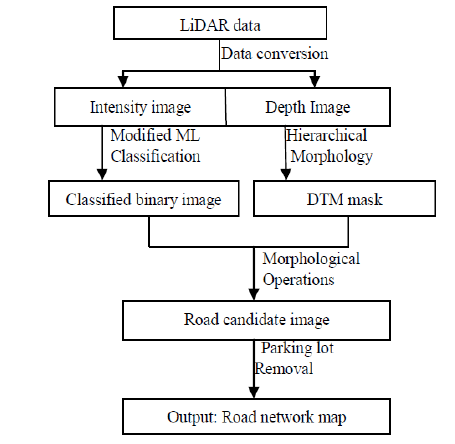
Figure 1. Workflow of the proposed algorithm In the following sections the different modules of the algorithm are described in